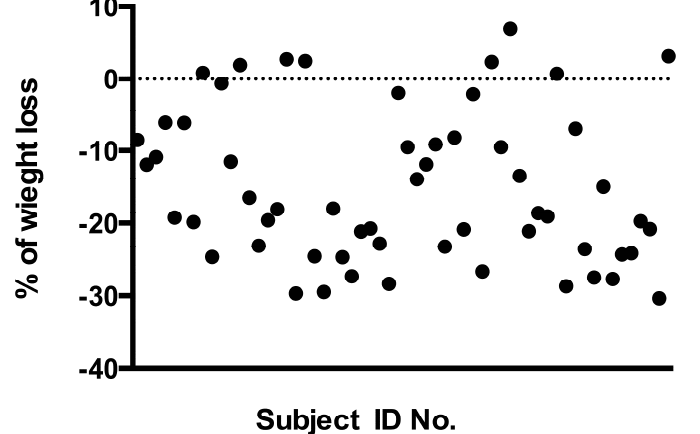
Figure 3. Changes in weight (% of change) of each subject ( t 6 compared to t 0). Basal value is represented by the line zero. Each circle represents a single